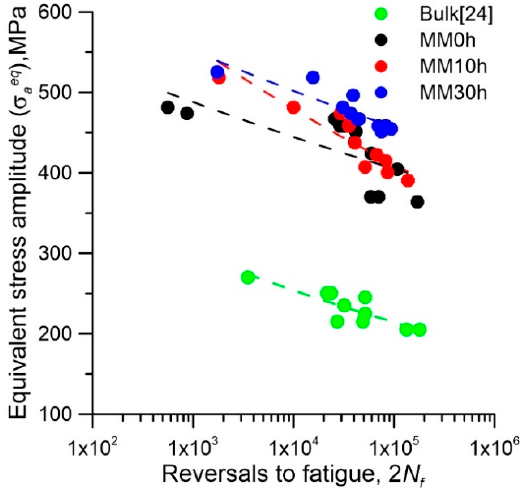
Figure 7. The dependence of the fatigue life (2 N f ) on the equivalent stress amplitude ( σ eq a ) of harmonic-structured 316LN steels.